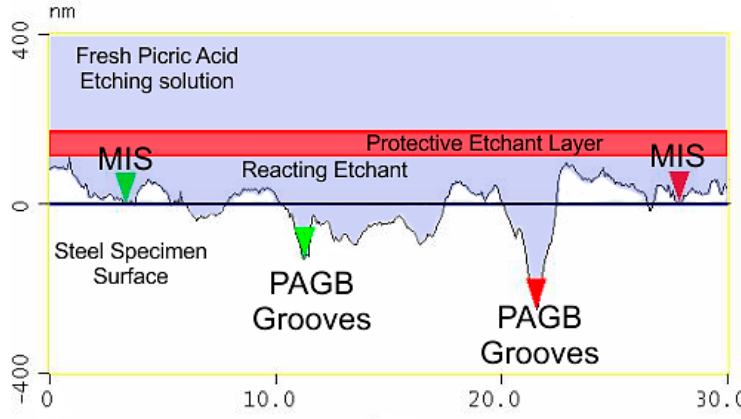
Figure 14. Illustration of the successful etching mechanism using atomic force microscopy (AFM).